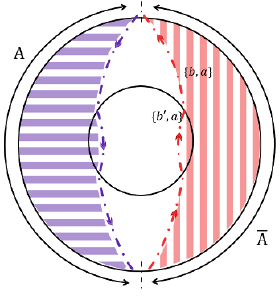
Figure 32 . Schematic plot of the intermedi- ate cuts and (cid:12)nal cuts during the process of the greedy algorithm when (cid:20) c = a= 2.